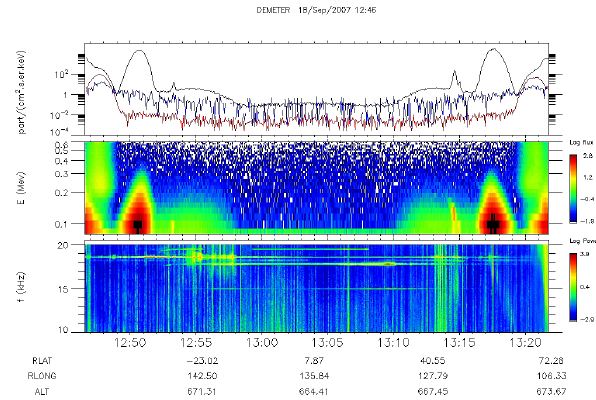
Fig. 5. Same format as Figs. 1 and 4, for 18 September 2007 be- tween 12:46 and 13:22UT, when NWC was